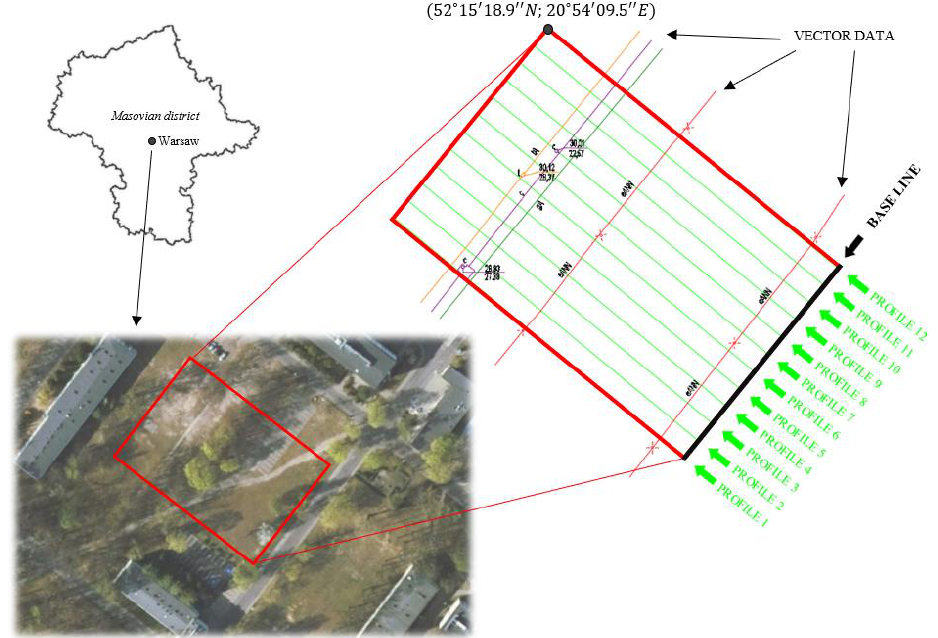
Figure 2. Test area with baseline and marked measurement profiles.